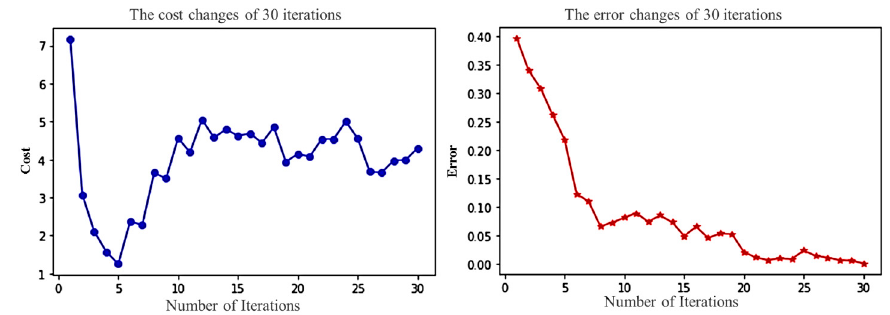
Figure 7. Variations in cost and error in RBM training.